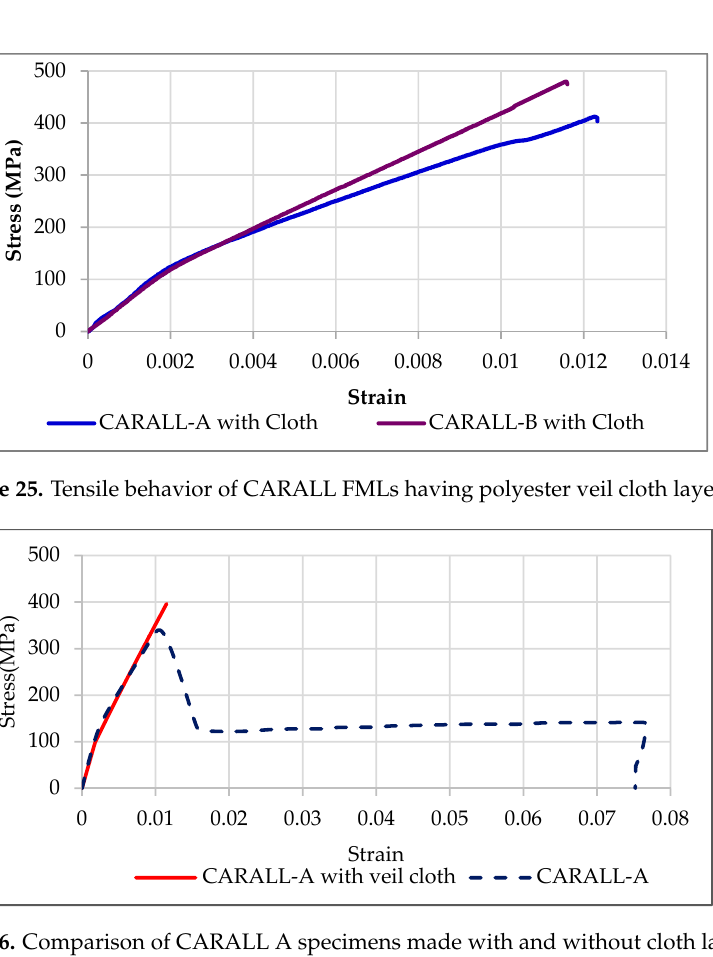
Figure 26. Comparison of CARALL A specimens made with and without cloth layers.